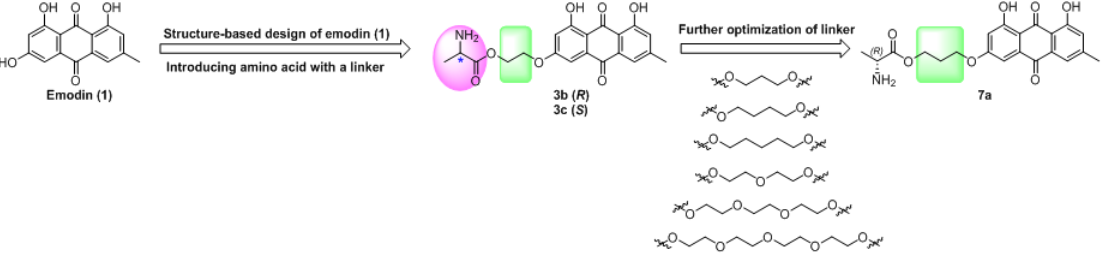
Figure 2. Design of emodin derivatives with varying lengths of diol linkers.